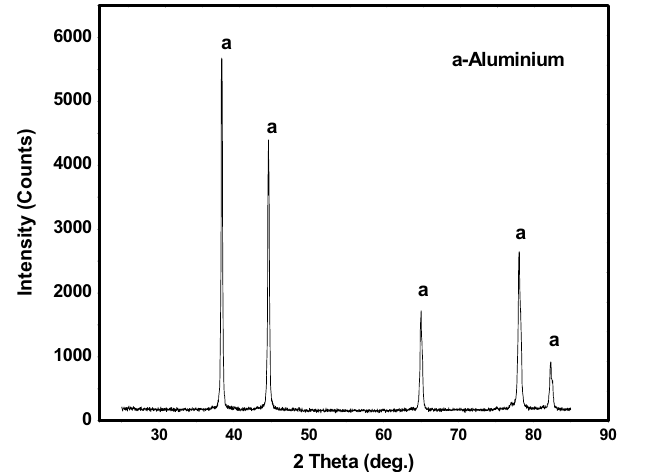
Figure 3. XRD of unreinforced Aluminium (Al6063).